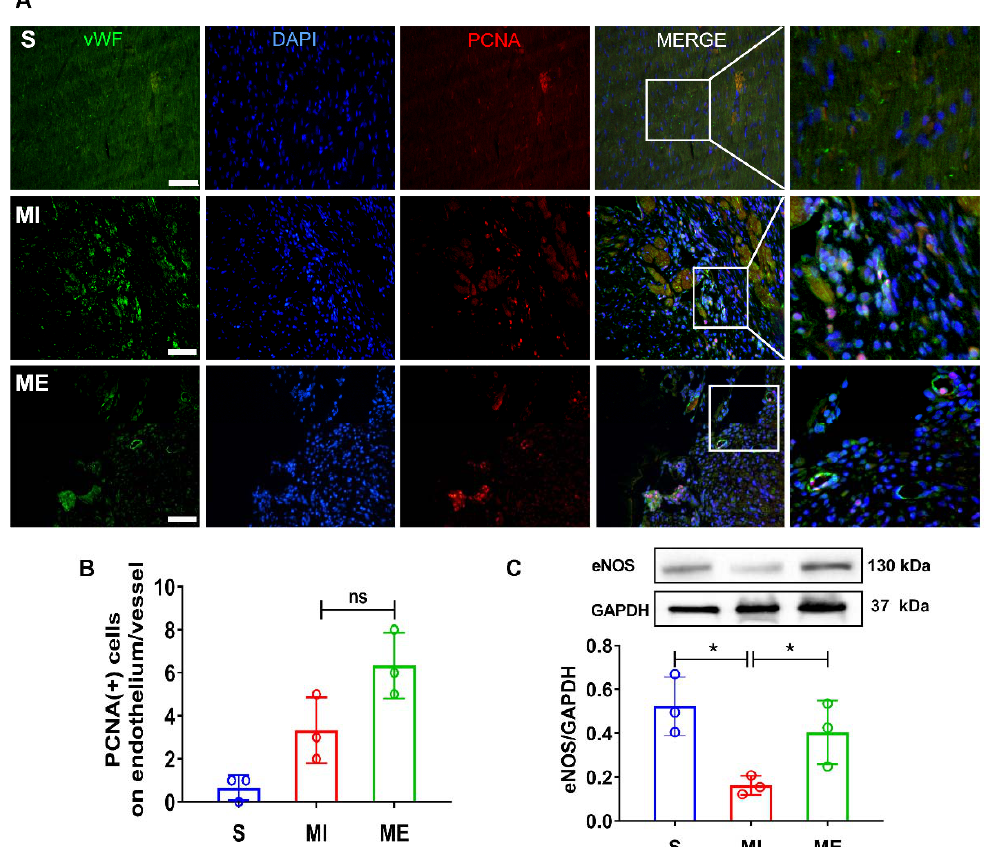
Figure 3. Post-myocardial infarction (MI) aerobic exercise training promotes cardiac angiogenesis and upregulates endothelial nitric oxide synthase (eNOS) in adult male rats. ( A ) Representative pictures of immunofluorescent staining of proliferating cell nuclear antigen (PCNA)/von Willebrand factor (vWF) (markers of angiogenesis) in rat heart paraffin sections. Whereas vWF indicates green fluorescence-labeled vascular endothelium, DAPI is blue fluorescence-labeled nuclei and PCNA is red fluorescence-labeled neonatal nuclei (scale bar = 200 µ m; n = 3/group). ( B ) Bar graph shows quantitative results of the respective intensity of immunofluorescence. ( C ) Representative pictures of western blots for detecting cardiac expression levels of the angiogenesis ‐ related protein—eNOS and bar graph of the averaged densitometry results of eNOS protein in rat myocardium ( n = 3/group). Abbreviations : S, sham control group; MI, myocardial infarction group; ME, post ‐ MI exercise trained group. Symbol * indicates p < 0.05 between the relevant groups that are compared.